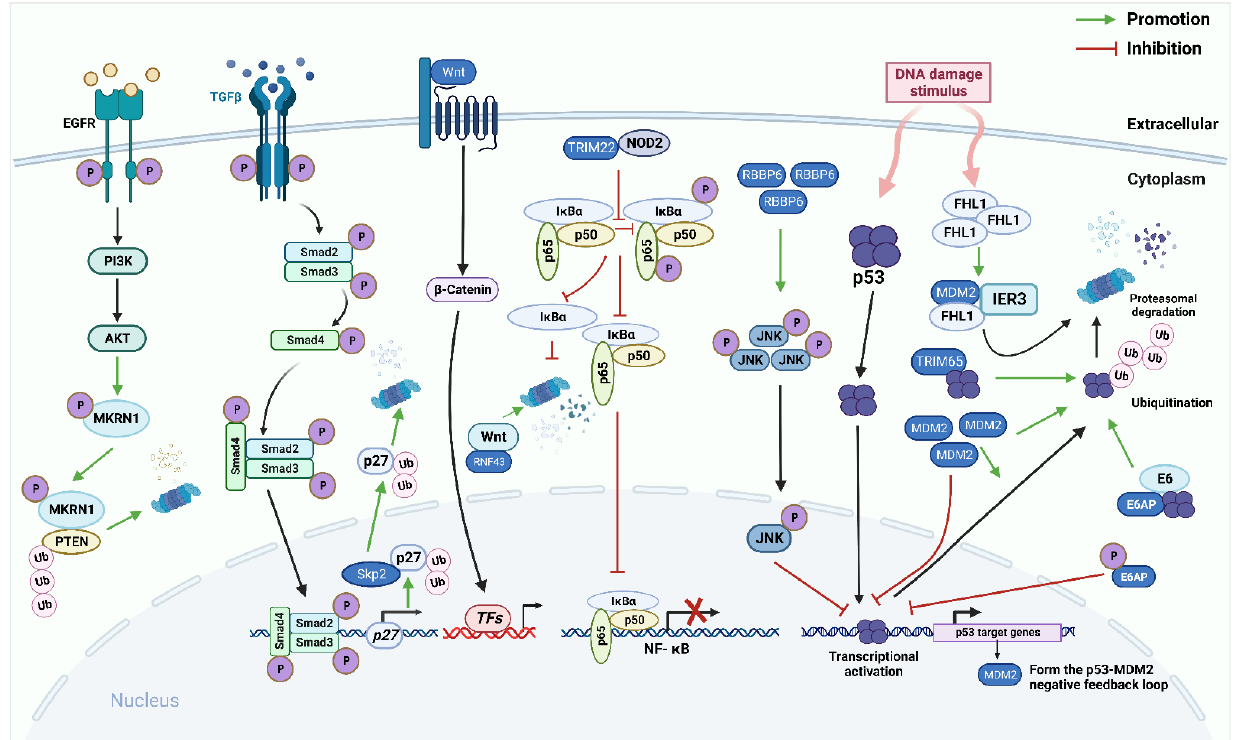
Figure 2. The role of E3 ligases in the p53 pathway, the Nuclear Factor Kappa-B (NF- κB) pathway, the EGFR pathway, the Wnt/β -catenin pathway, the TGF- β/Smad pathway in endometrial carcinoma (EC) and cervical cancer (CC). The p53 signaling pathway: E3 ligases murine double minute 2(MDM2), E6AP, and TRIM65 directly bind to p53 and promote ubiquitination degradation of p53. p53 protein, in turn, induces MDM2 to regulate itself through self-ubiquitination. Furthermore, RBBP6 promotes the phosphorylation of c-Jun NH2-terminal kinase (JNK) to regulate the expression of p53. In CC cells, FHL2 binds to IER3 and MDM2 to form a ternary complex that allows for efficient MDM2-mediated degradation of IER3 by enhancing the association between MDM2 and IER3. NF- κB pathway: E3 ligase TRIM22 directly binds to nucleotide -binding oligomerization domain-containing protein 2 (NOD2). Reducing the phosphorylation of p65 and IκBα reduces NF - κB signal transduction. Epidermal growth factor receptor (EGFR) pathway: makorin RING finger protein 1 (MKRN1) can be phosphorylated by the EGFR/PI3K/AKT pathway to continuously degrade PTEN protein in a K48- dependent manner. Wnt/β -catenin pathway: RNF43 directly interacts with Wnt and promotes its degradation, thereby inhibiting continuous activation of the Wnt/β -catenin pathway. TGF- β/Smad pathway: Activated TGF - β ligand in teracts with two transmembrane receptors TβRI and TβRII, to form a tetrameric complex. Constitutively activated TβRII phosphorylates and activates TβRI, which directly phosphorylates downstream transcription factors Smad 2 and Smad 3 through its serine/threonine kinase activity. Activated Smad2 or Smad3 can bind to Smad4, migrate to the nucleus, and bind to different TFs to achieve excessive activator or suppressor activity. SCF Skp2/Cks1 directly interacts with p27 and ubiquitinate it.